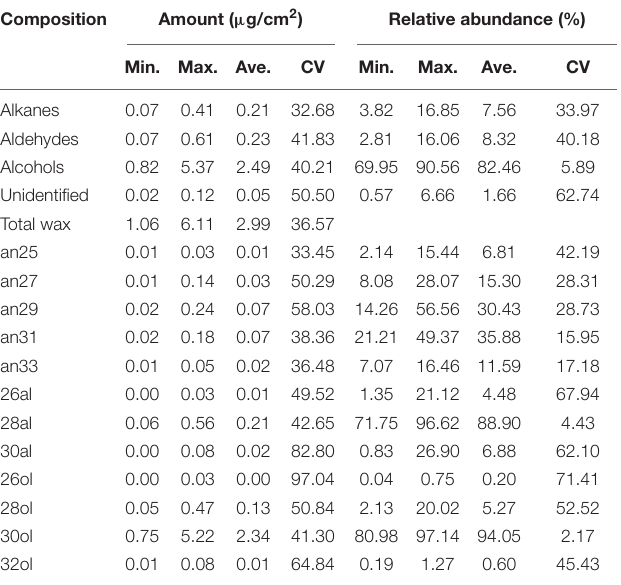
TABLE 1 | Variations of the amounts and relative abundance of wax compositions across 30 Medicago ruthenica populations. Composition